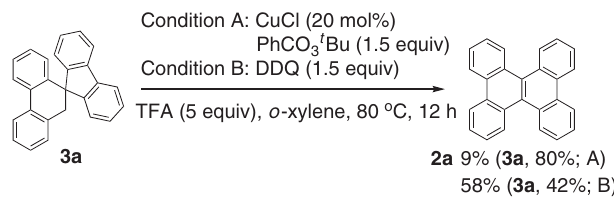
Figure 6 | Reactions using the spirocyclic substrate 3a for the formation of 2a. Both single-electron oxidation conditions A and B afforded the corresponding product 2a , indicating the involvement of spirocyclic radical species B and C for subsequent 1,2-aryl